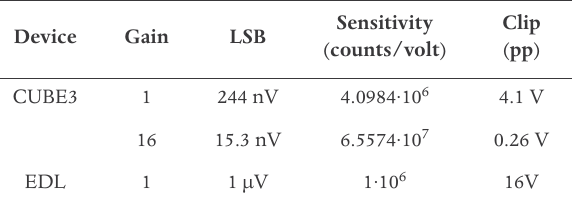
Table 2. Main characteristic of the different acquisition systems used. Table 3. Main characteristic of the seismic sensors used.